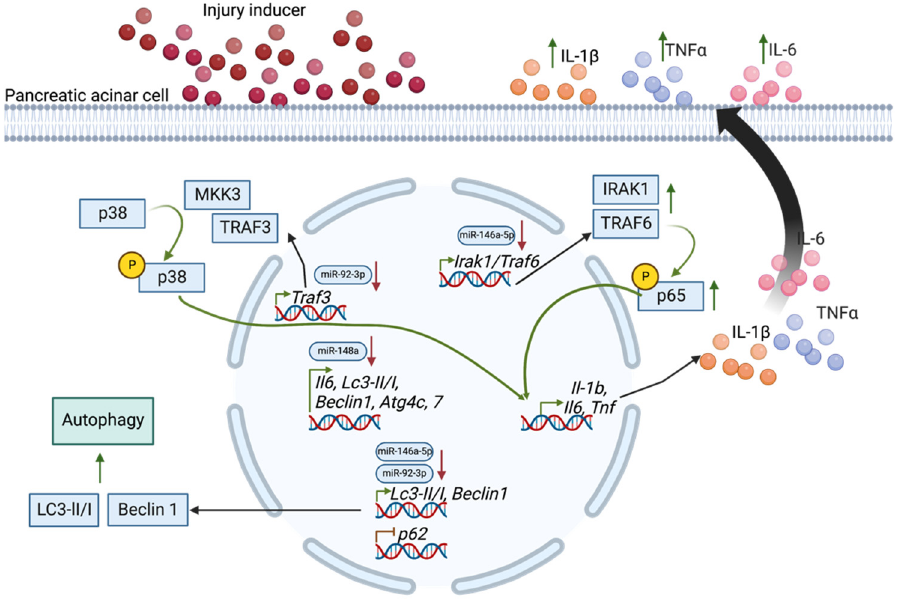
Figure 2. MiR-92-3p, 146a-5p, and 148a in the regulation of inflammatory response and autophagy during acute pancreatitis (please see text for details). Created with BioRender.com.